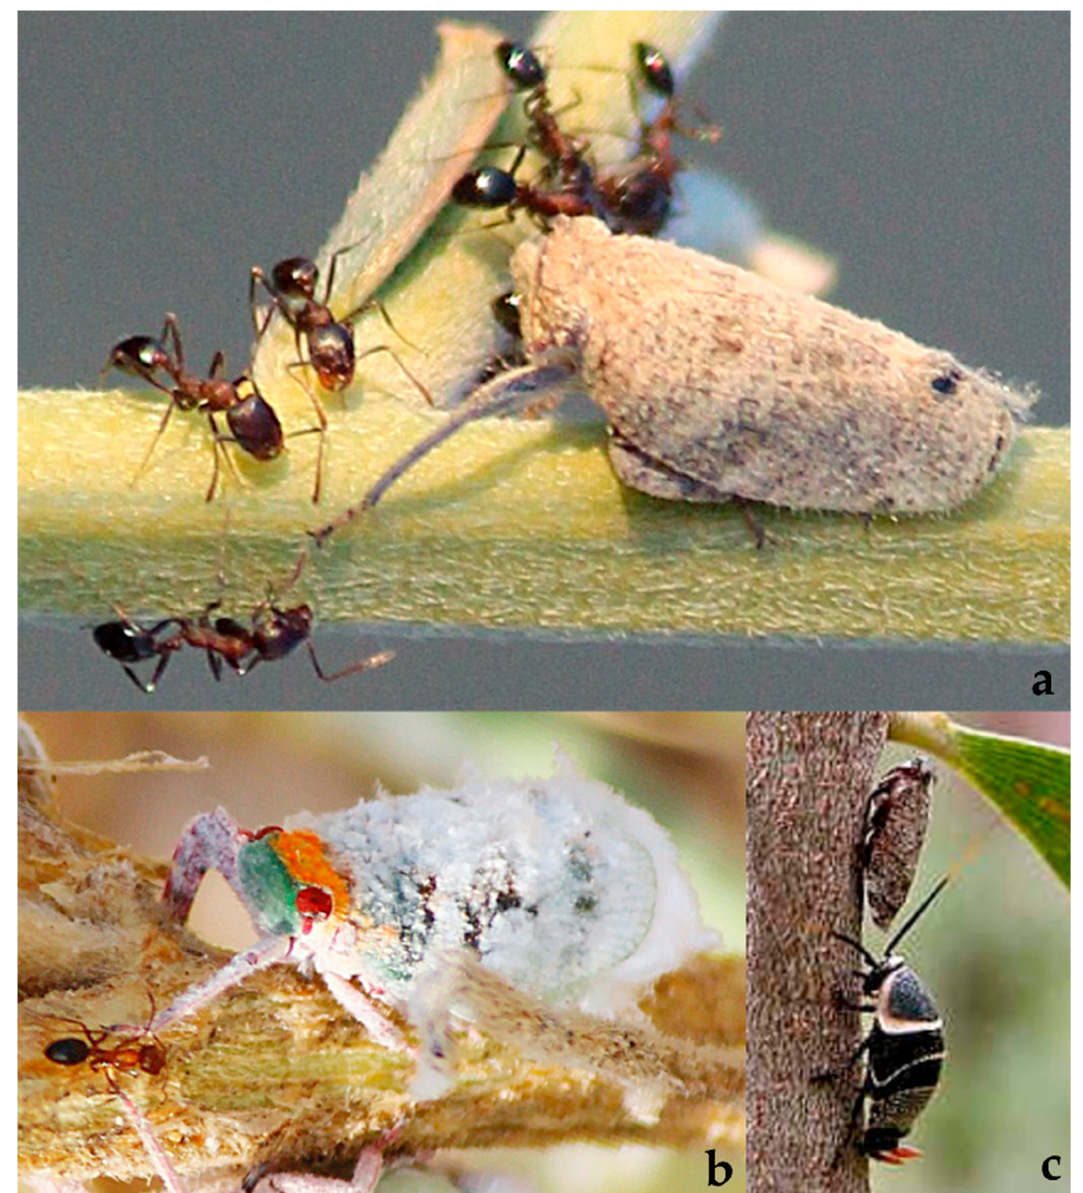
Figure 6. Eurybrachidae ( a ) Eurybrachys sp. tended by Formicidae indet., India: Amar Sagar, Jaisalmer Rajastan, 18.12.2020, adult male on Crotalaria sp. (Fabaceae), obs. S. Sunder Meena; ( b ) Eurybrachys sp. tended by Formicidae indet., India: Amar Sagar, Jaisalmer Rajastan, 18.12.2020, adult female on Heliotropium sp. (Boraginaceae), obs. S. Sunder Meena; ( c ) Gelastopsis insignis Kirkaldy, 1906 tended by Blattodea indet., Australia: Queesnland, Brisbane, 27°28 ′ 04 ″ S 153°01 ′ 41 ″ E, adult on Acacia sp. (Fabaceae), obs. P. Chew.